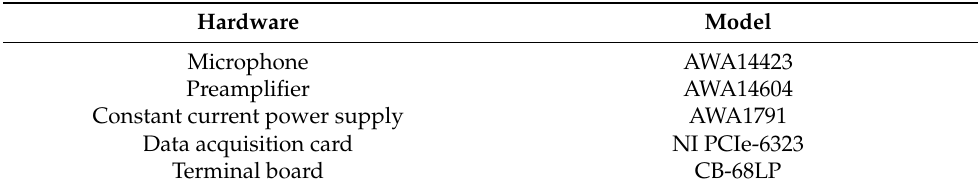
Table 1. Hardware details of the sound signal acquisition system.